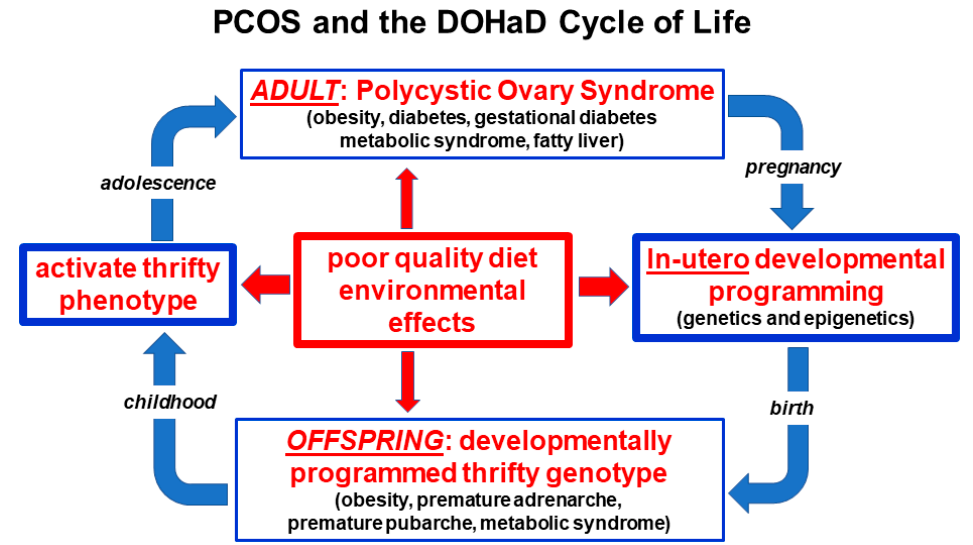
Figure 2. Nutritional and environmental influences throughout the life course and the perpetuation of the transgenerational inheritance of polycystic ovary syndrome. Adapted with permission from Ref [28]. 2020, Journal of